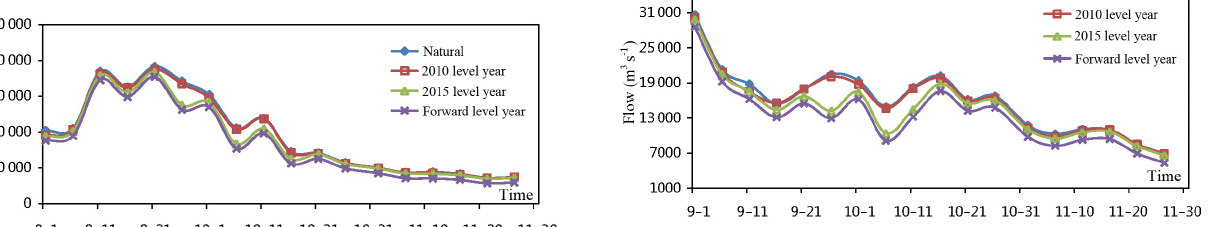
Figure 5. Process of Yichang hydrological station from September to November in slightly rainy year (1973).